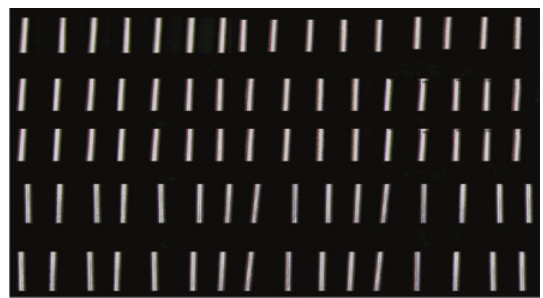
Figure 4: Specimen pins (AA2014/eggshell/SiC hybrid green metal matrix composite) used in the wear test.